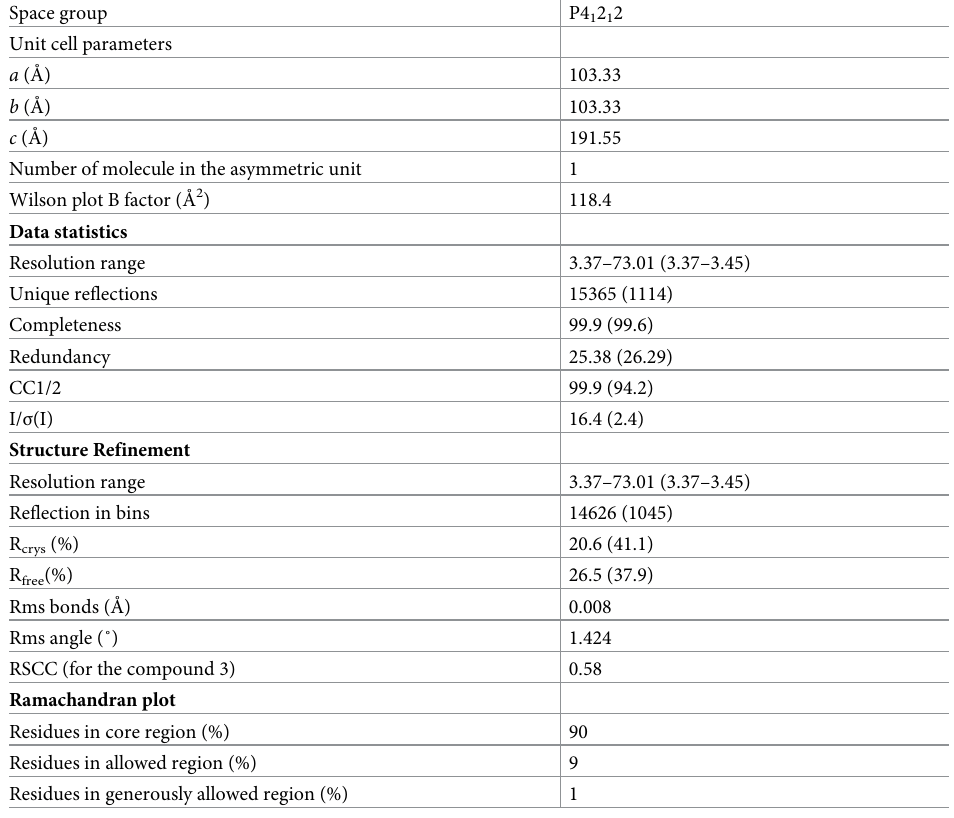
Table 1. Crystal parameters, data collection statistics and refinement statistics of compound 3-TR complex. Space